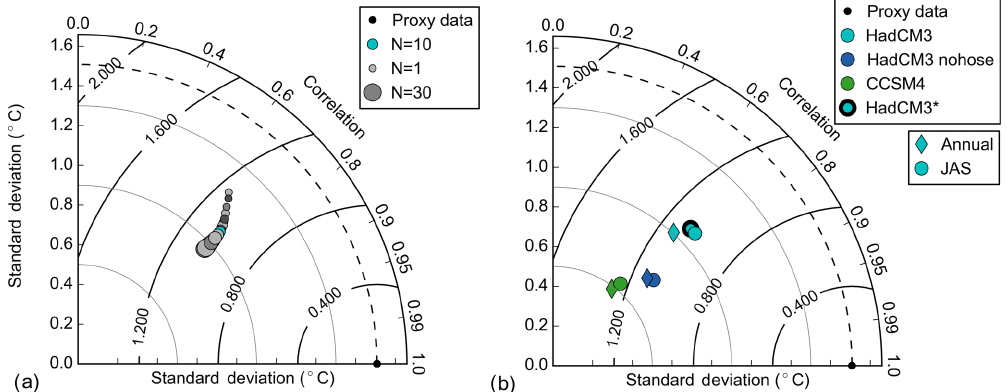
Figure 5. Taylor diagram showing the agreement between the proxy data and the surrogate time series produced using (a) different number of analogs (1–30) using the main HadCM3 model pool. Increasing size of circles corresponds to increasing number of analogs. N = 10 is marked in blue. (b) Different model pools (legend). The dashed black line indicates the standard deviation of the proxy data. Full black lines indicate the centered rms difference (labels, in ◦ C). All values are means over the 14 core locations where correlation and standard deviation are calculated for the 30–40kyr time